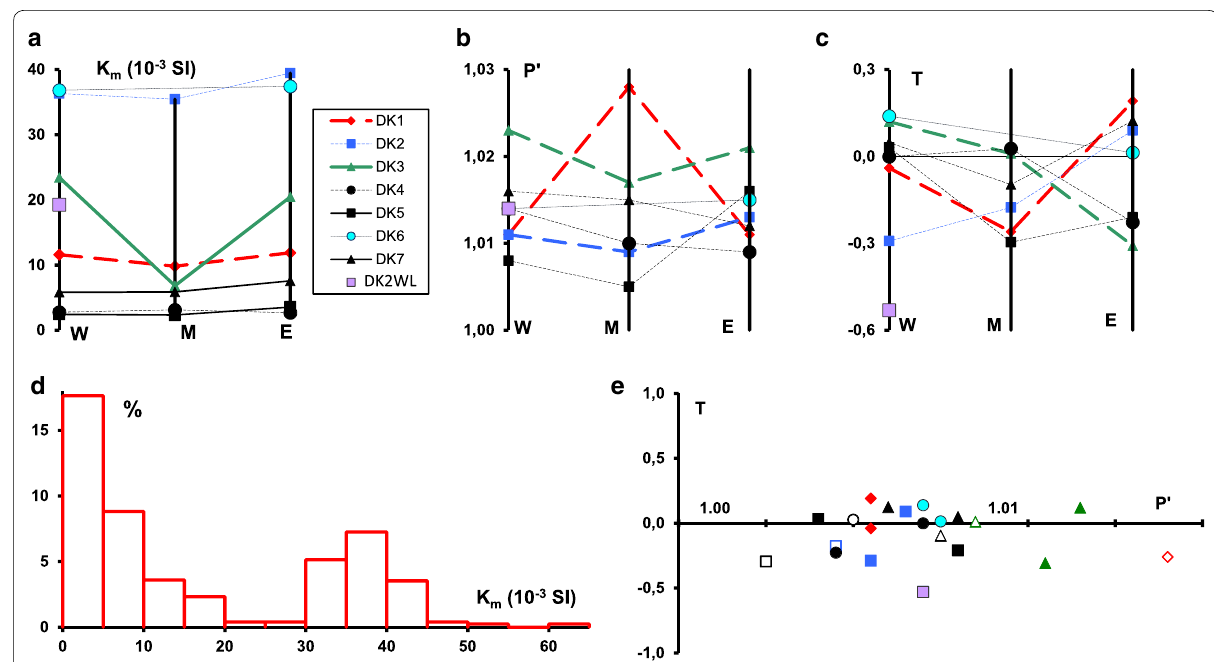
Fig. 2 AMS scalar parameters. a – c Mean values of K m (in 10 –3 SI): P ′ , and T in the western (W), middle (M) and eastern (E) parts of the studied dikes, d distribution of K m for all the specimens, e P ′ T diagram (Jelinek 1981) for mean values in different parts of the dikes (full squares and open symbols correspond to the marginal and central parts of the dikes, respectively; see b , c for